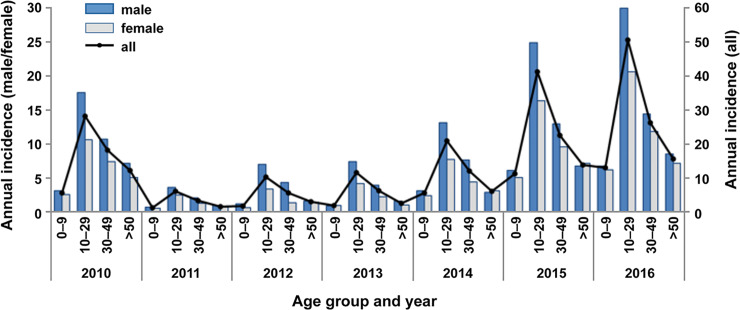
Incidence of dengue in Sabah by age group and gender, 2010–2016.Age- and gender-adjusted incidence rates (per 100,000 population) across Sabah during the 7-year period are shown for males, females and for both genders.